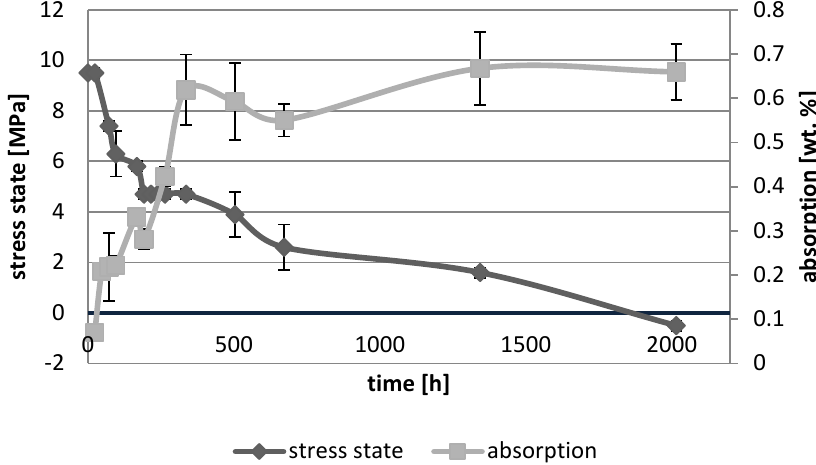
Figure 7. The relationship of absorption and stress state during water ageing (2016 h) of Glasiosite.